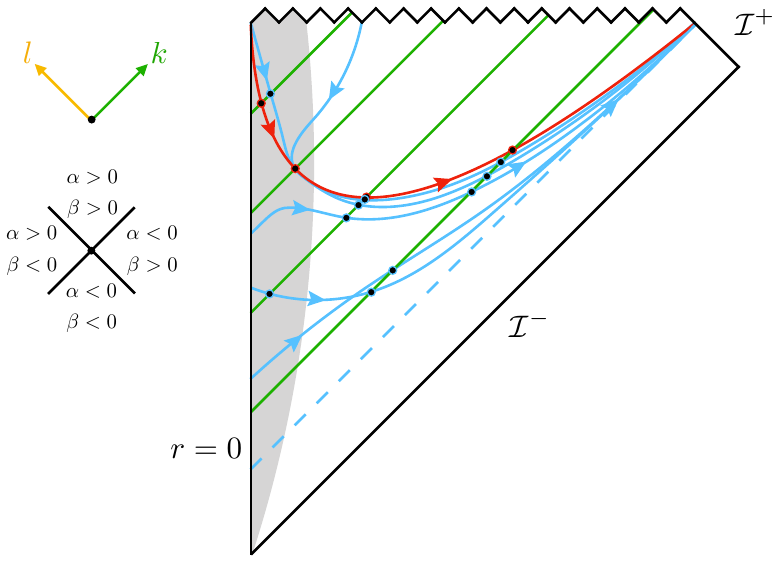
Figure 2 . Generalized (future) holographic screens inside a black hole formed from collapse. The holographic screen H is shown in red and has both a timelike and spacelike portion. Several examples of generalized holographic screens H 0 are illustrated by the blue curves. In this example, they can have both timelike and spacelike portions or can be purely spacelike. The limiting case of the event horizon (blue dashed line) also corresponds to a generalized holographic screen. A few representative light sheets N k ( (cid:27) ) are illustrated by the green lines and on these light sheets the codimension-two leaves (cid:27) of H (on which (cid:18) k = 0) and the leaves (cid:27) 0 of H 0 (on which (cid:18) k = 0) are 6 represented by the black dots; for each (cid:27) 0 H 0 there exists (cid:27) H for which (cid:27) 0 N k ( (cid:27) ). We will (cid:26) (cid:26) (cid:26) show that all of these screens obey an area law, with increasing area toward the past and outward directions, as illustrated by the arrows pointing in the direction of increasing (cid:28)